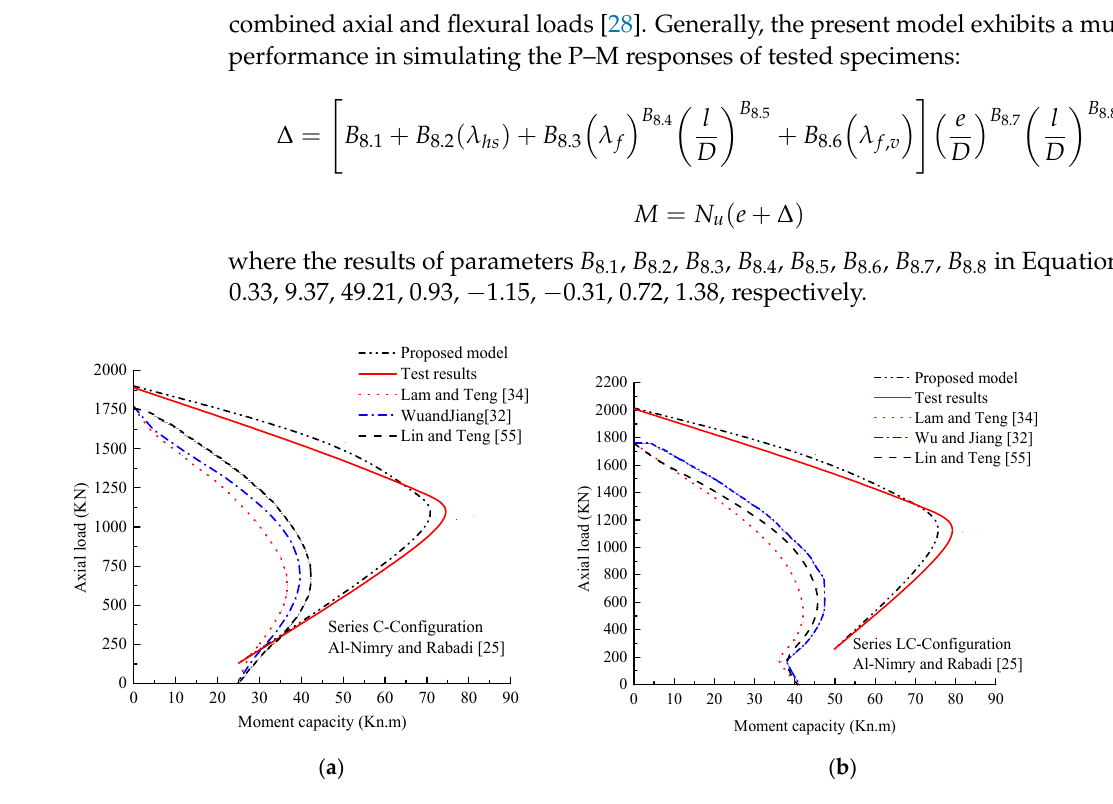
Figure 12. Predicting P – M interaction responses of selected specimens using existing and proposed models. ( a ) Columns strengthened with CFRP sheets only; ( b ) Columns strengthened with both lateral and longitudinal CFRP sheets.